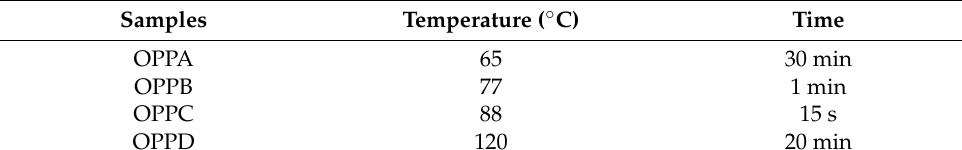
Table 6. Time/temperature binomials applied to the olive pomace paste (OPP).